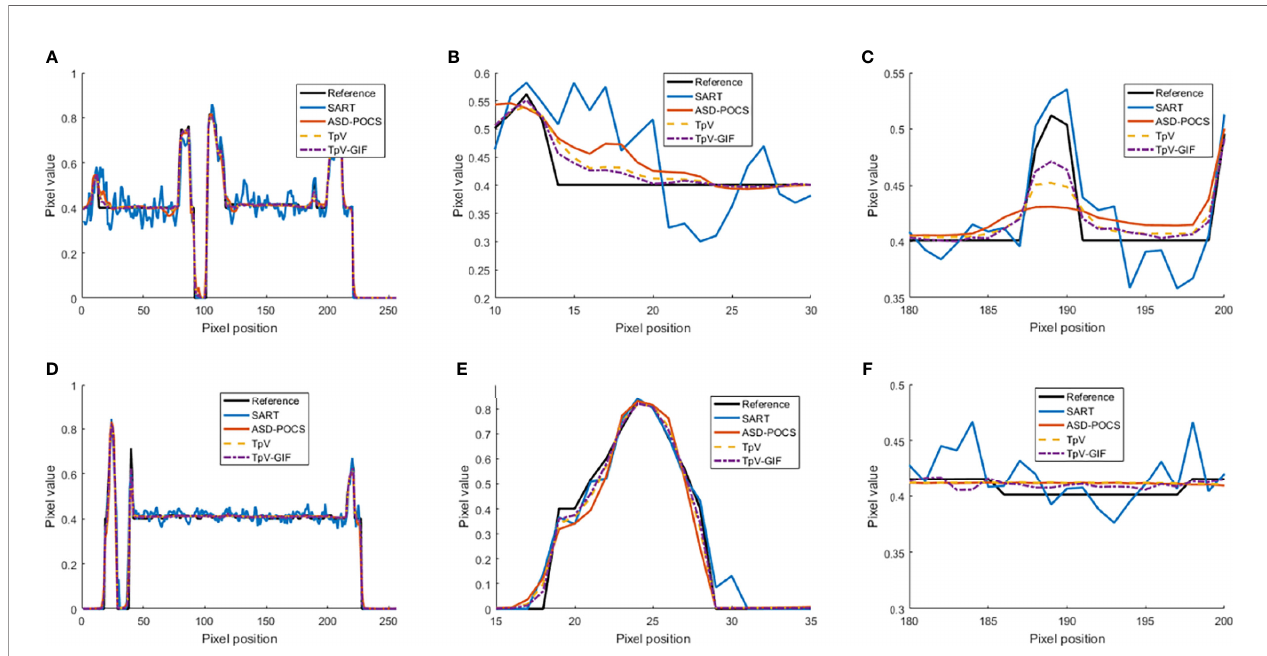
FIGURE 3 | Pro fi le curve images: (A) The full voxel curve of the 80th layer and 128 rows; (B, C) is a partial enlargement of (A) ; (D) the complete curve of the 128th row and 128 columns; (E, F) Is a partial enlargement of (D) .